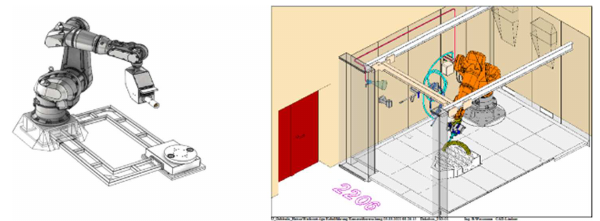
Fig. 8. Virtual planning and simulation of RWE01/RWE02 for the final decont